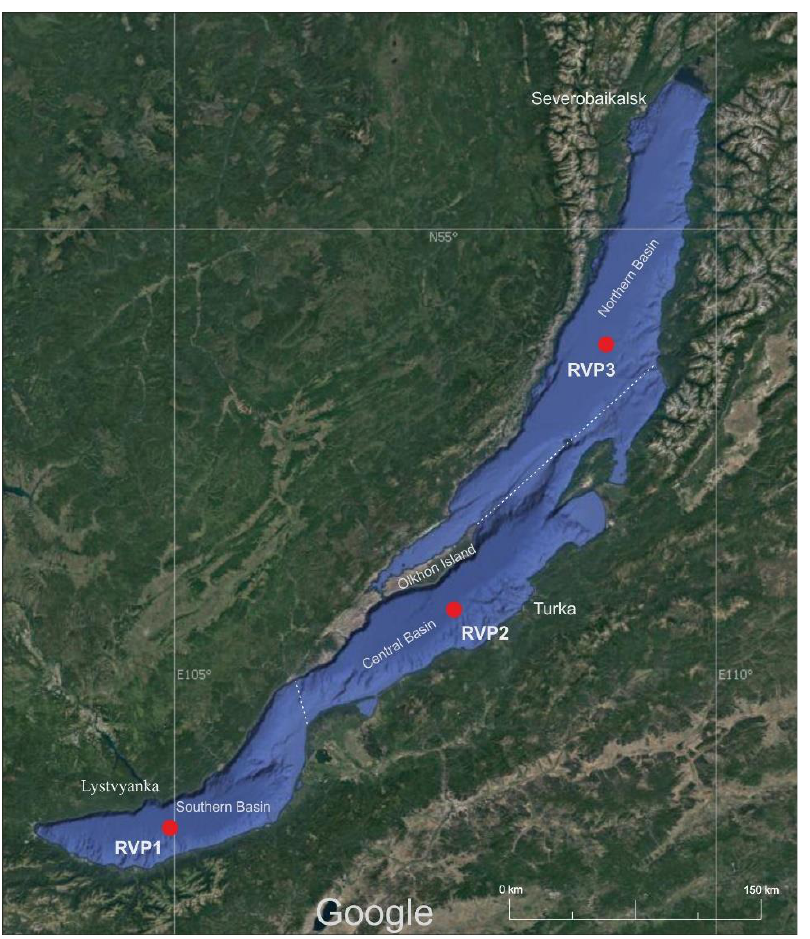
Figure 1. Map of the sampling area. Imagery from 2021 NASA, TerraMetrics, Map data © 2022